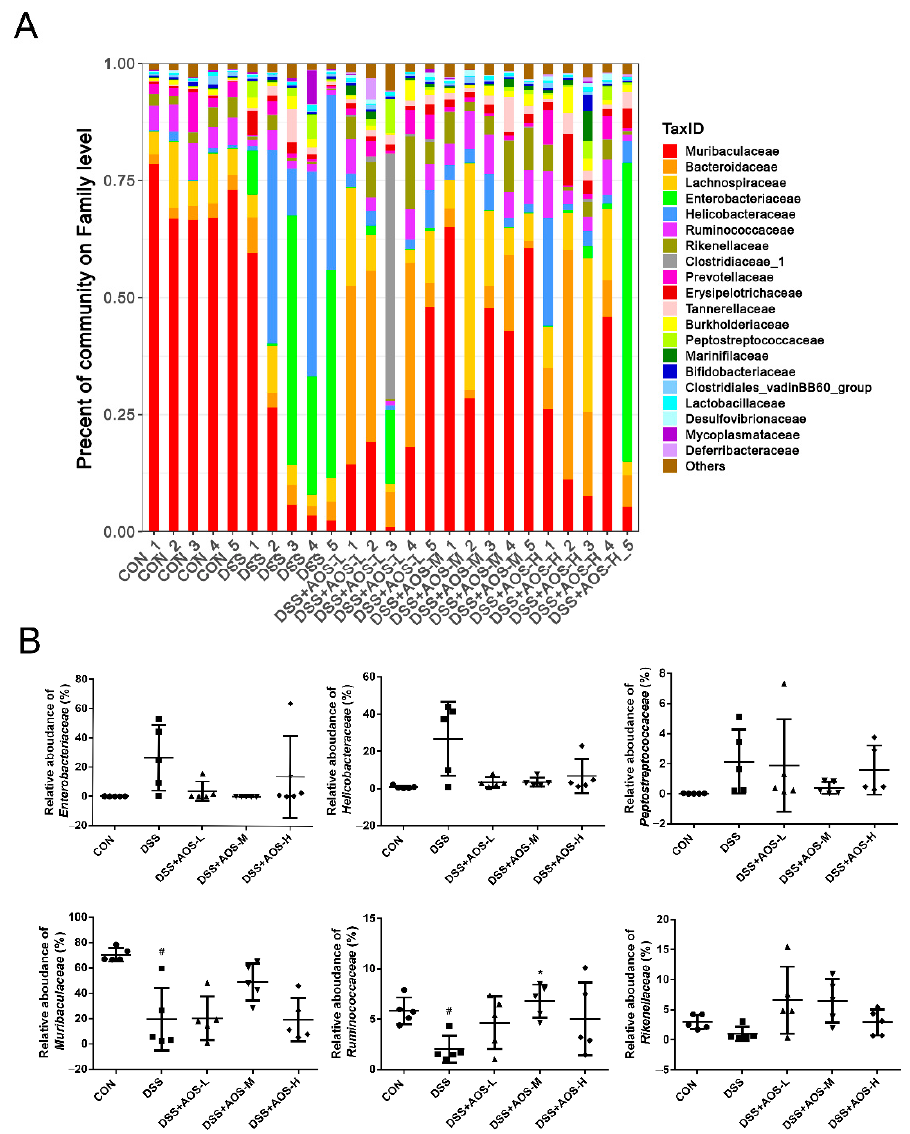
Figure 8. Effects of AOS on the gut microbial composition of colonic contents at family level. ( A ) Bacterial taxonomic profiling at family level. ( B ) Relative abundance of gut microbiota at family level. # p < 0.05 vs. Control group, * p < 0.05 vs. DSS group, n = 5.